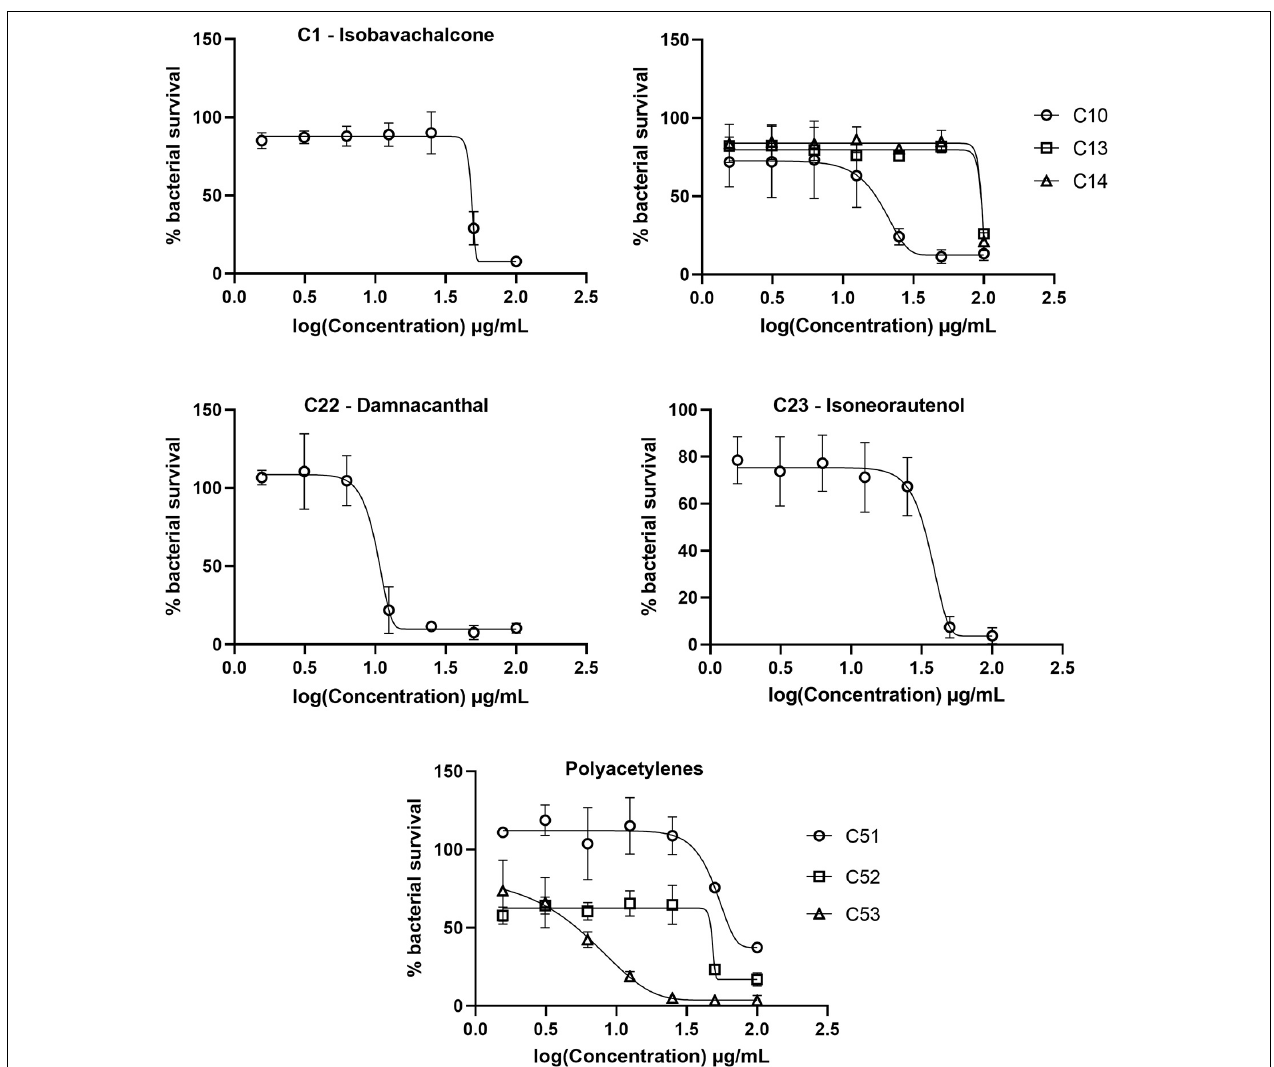
FIGURE 6 | Dose response curves of Mycobacterium tuberculosis treated with hit compounds. M. tuberculosis was treated for 7 days with compounds ranging in concentration from 100 µ g/mL to 1.56 µ g/mL. Bacterial survival was measured after overnight incubation with CellTiter-Blue to establish minimum inhibitory concentrations (MICs). Data points are expressed as mean % survival relative to drug-free controls from duplicate biological replicates. Error bars represent the standard